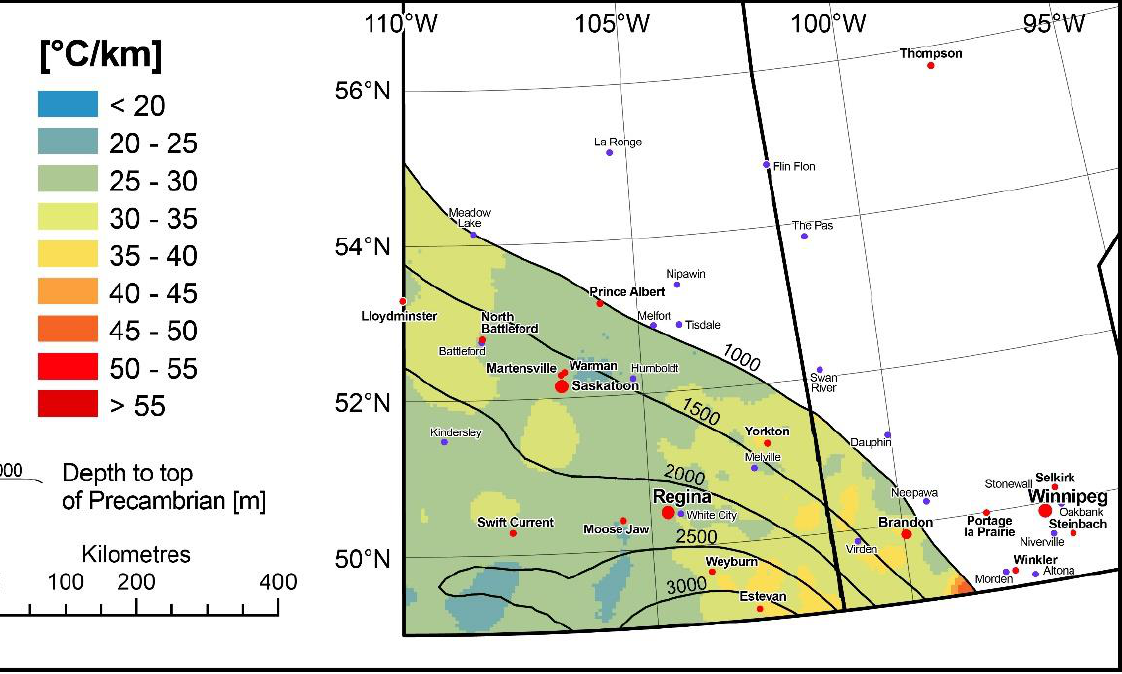
Figure A1. Geothermal gradient — Saskatchewan – Manitoba WCSB.